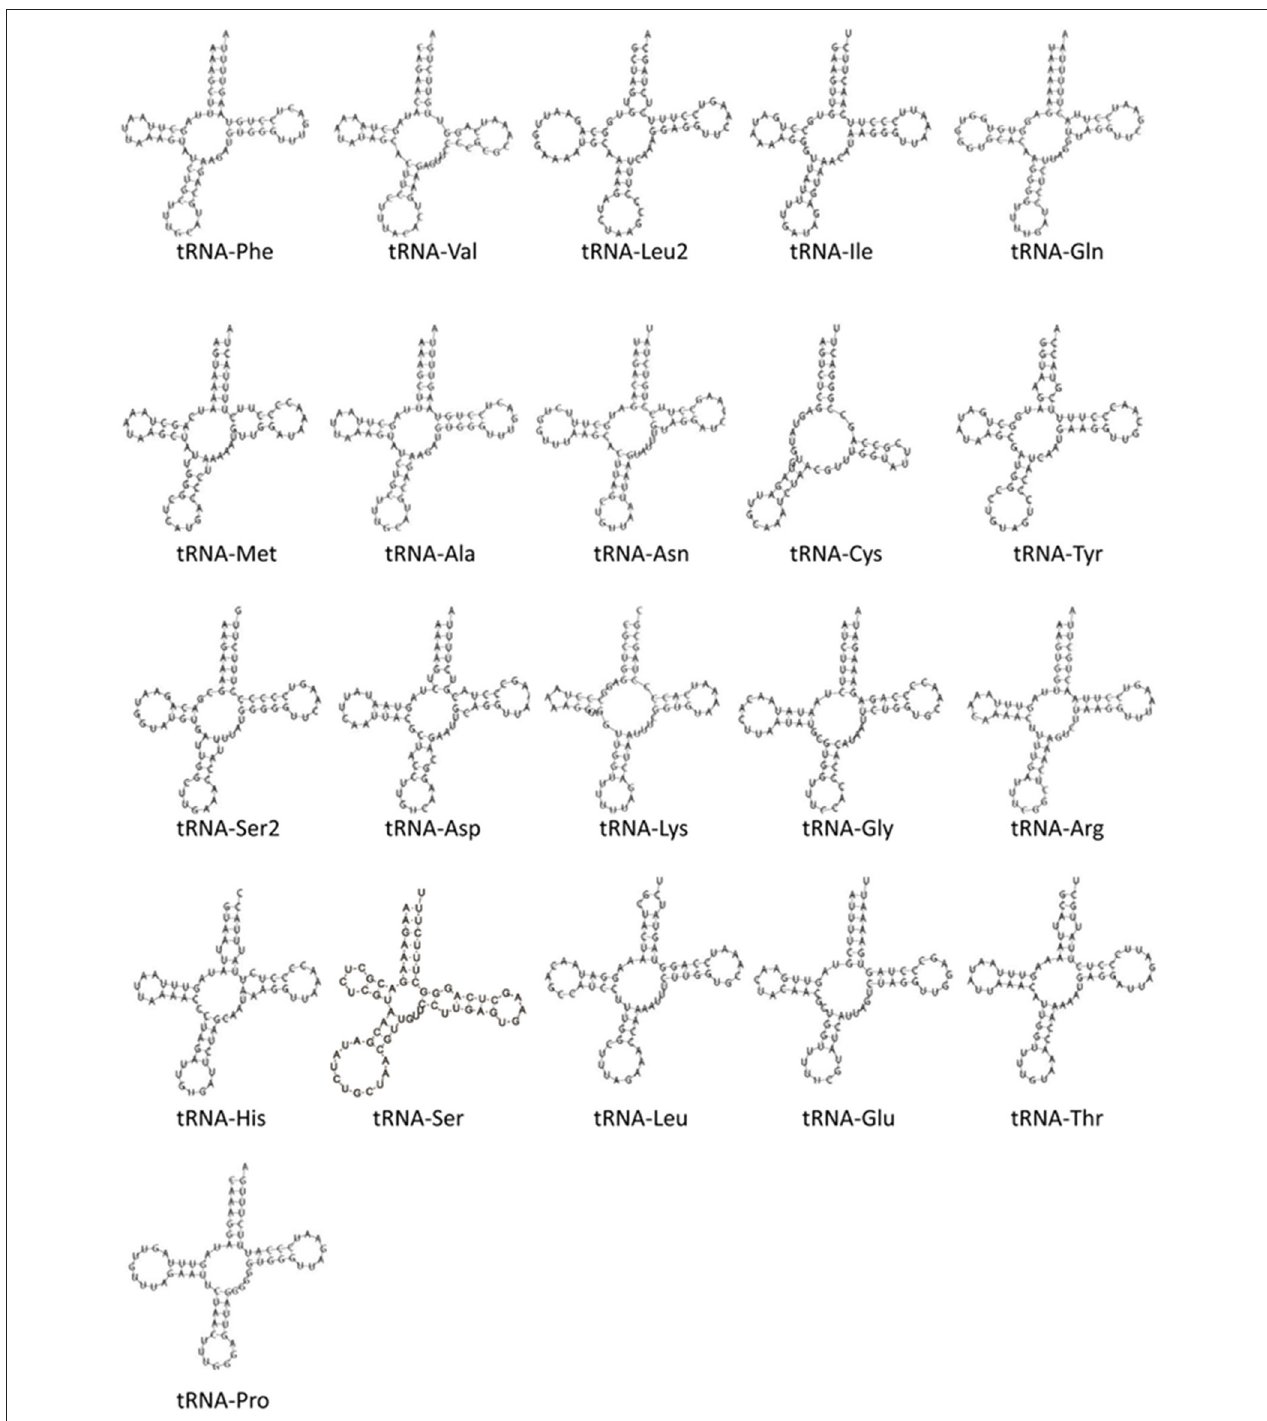
FIGURE 9 | Predicted secondary structures of identified mitochondrial tRNAs in the A. limnaeus mtgenome. The A. limnaeus tRNA-Ser was identified by mapping the N. furzeri tRNA-Ser to the A. limnaeus mtgenome and was folded using Geneious. All other tRNAs were folded by MITOS.